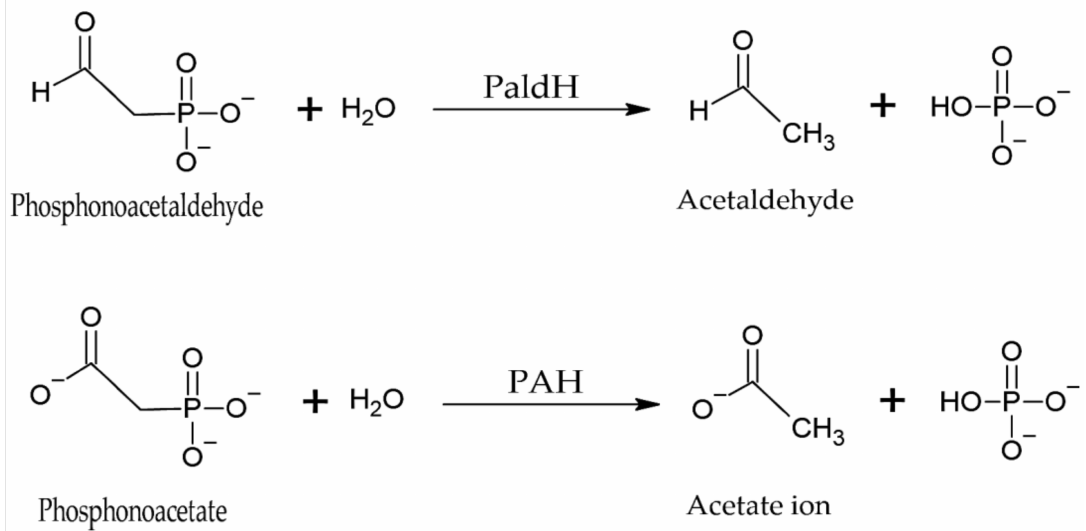
Figure 5. The catalytic reaction of phosphonatases. PaldH: phosphonoacetaldehyde hydrolase, PAH: phosphonoacetate